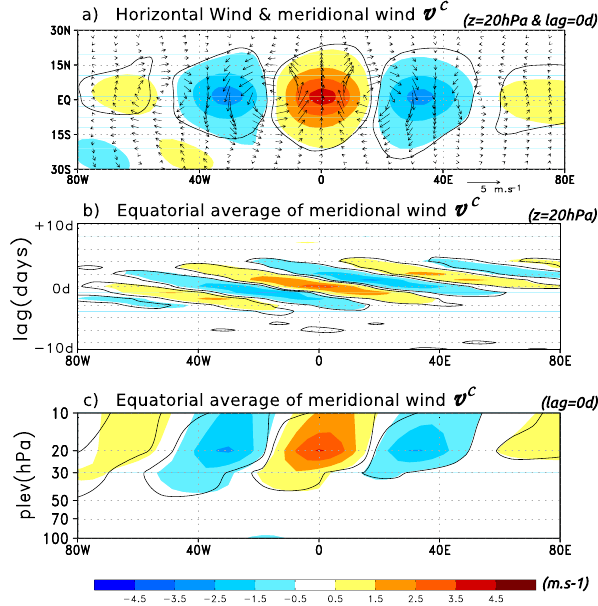
Fig. 11. RGW composites from ERAI at 20hPa calculated during negative phases of the QBO at 50hPa (i.e. when the zonal wind is negative at 50hPa and positive at 20hPa). (a) Meridional wind v C (shading) and horizontal wind (u C ,v C ) (arrows) at z p = 50hPa and l = 0 day lag. (b) Hovmöller diagram of the meridional wind v C at z p = 20hPa. (c) Longitude–altitude cross section of the meridional wind v C averaged over the equatorial band. Shaded areas of merid- ional wind values are in red (blue) for positive (negative) (ms − 1 ). The black lines delimit the 99% significant regions according to a Student t test for the meridional